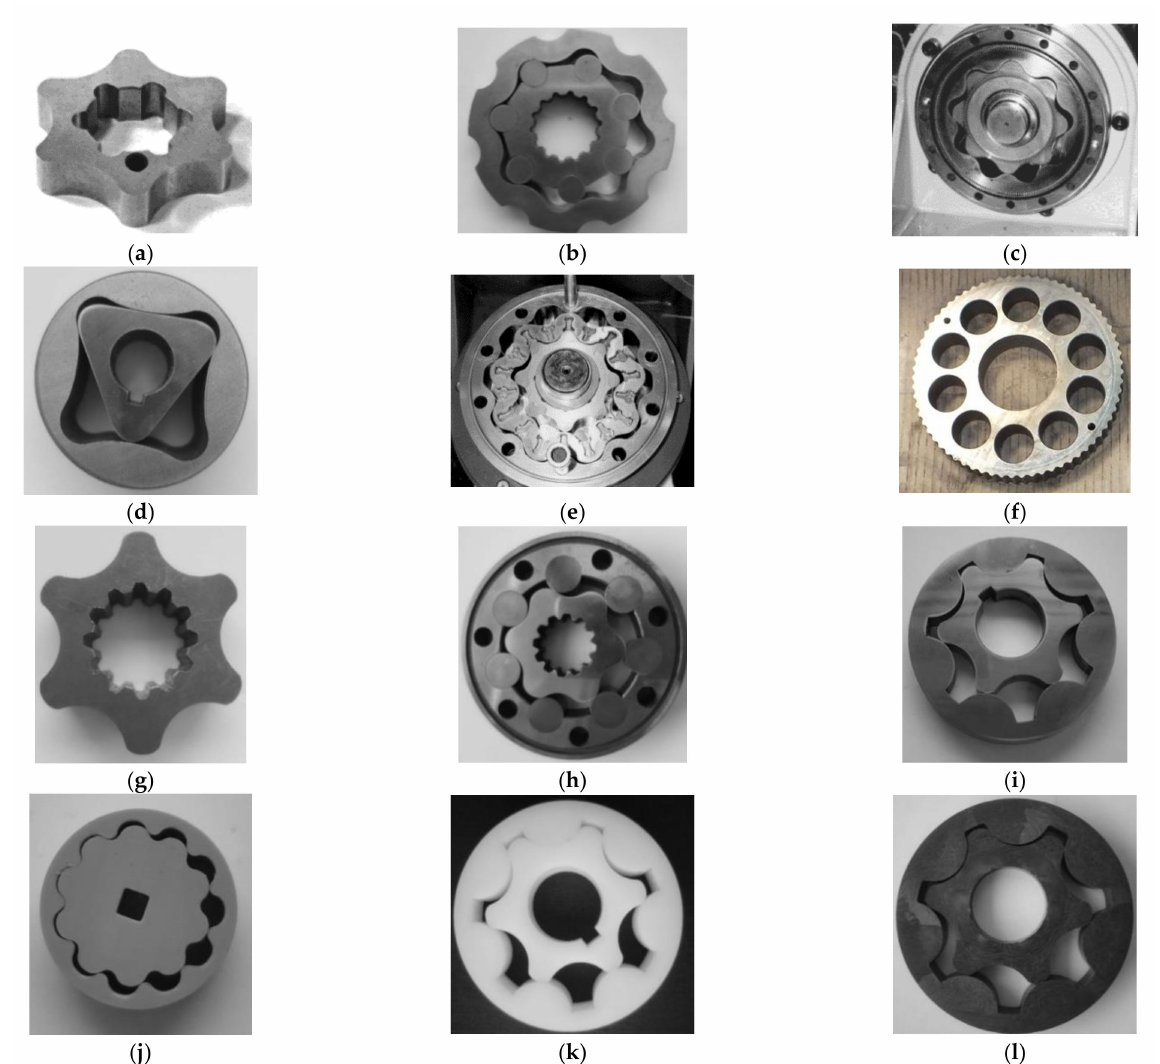
Figure 14. Gerotor and orbital gear systems manufactured using different methods: ( a – c )—systems manufactured by the use of an end mill; ( d – f )—systems manufactured by the use of electrical discharge manufacturing; ( g – i )—systems manufactured by the use of hobbing, broaching and grinding; ( j – l )—plastic systems manufactured by the use of injection molding and